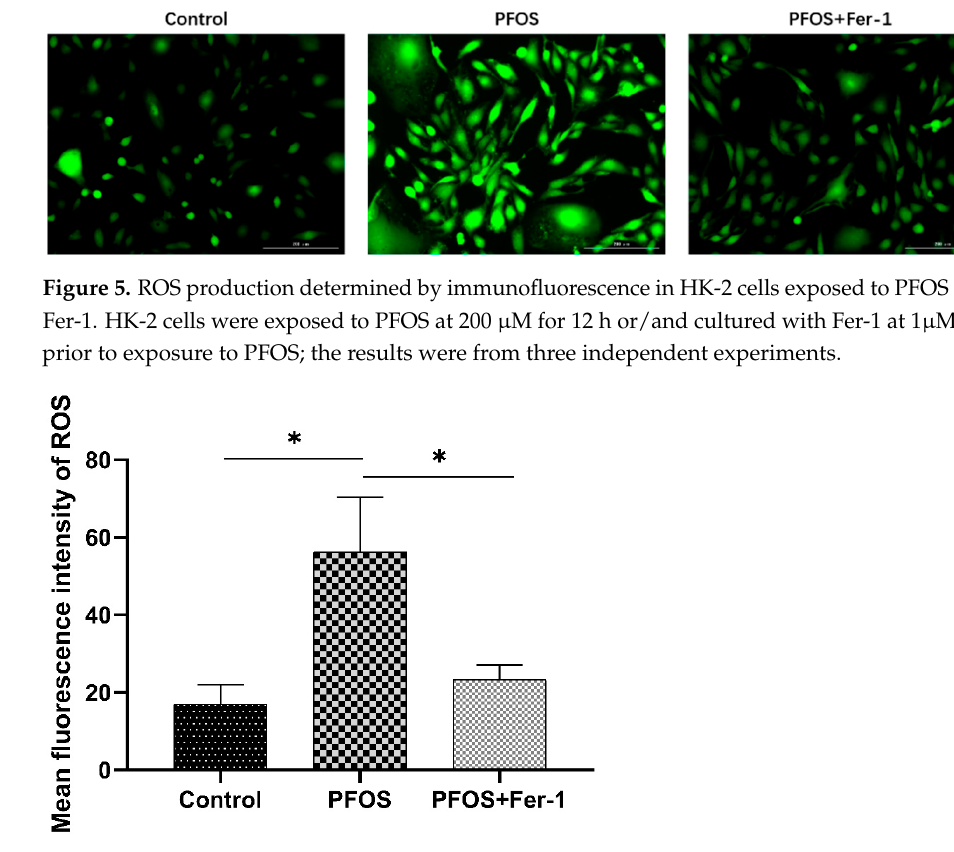
Figure 6. Comparison of immunofluorescence intensity of HK-2 cells exposed to PFOS or/and Fer-1. HK-2 cells were exposed to PFOS at 200 µ M for 12 h or/and cultured with Fer-1 at 1 µ M for 2 h prior to exposure to PFOS; the results were from three independent experiments. Data were expressed as mean ± SD (n = 3), * p <